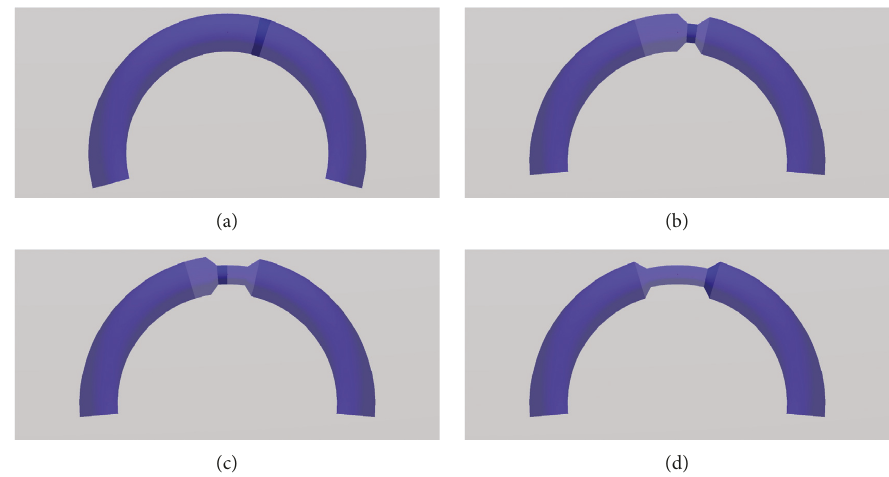
Figure 7: Example of virtual clad-removal operation (when R c (cid:31) 1.7 mm and L (cid:31) 5mm). (a) Step 0. (b) Step 1. (c) Step 2. (d) Step